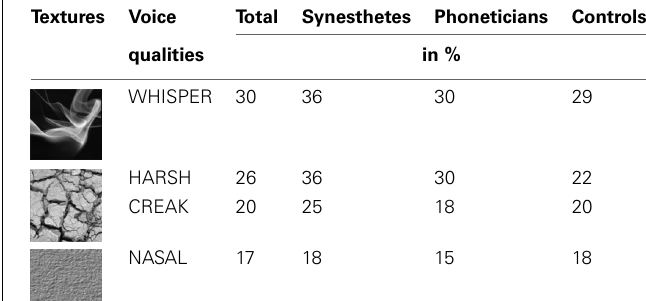
Table 5 | The four voice quality—texture associations with highest agreement between and across